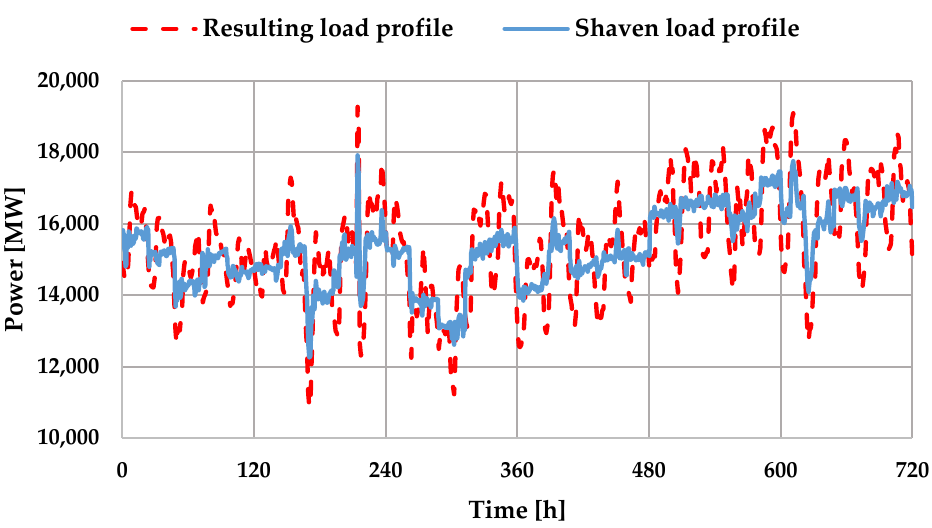
Figure 9. Benefits to the monthly load profile after employing the proposed operation algorithm.